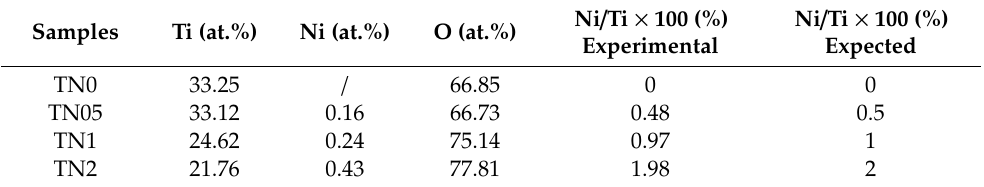
Figure 3. SEM images of undoped and all Ni-doped TiO 2 powders prepared by the co-precipitation route. Table 2. EDX results for TN0, TN05, TN1 and